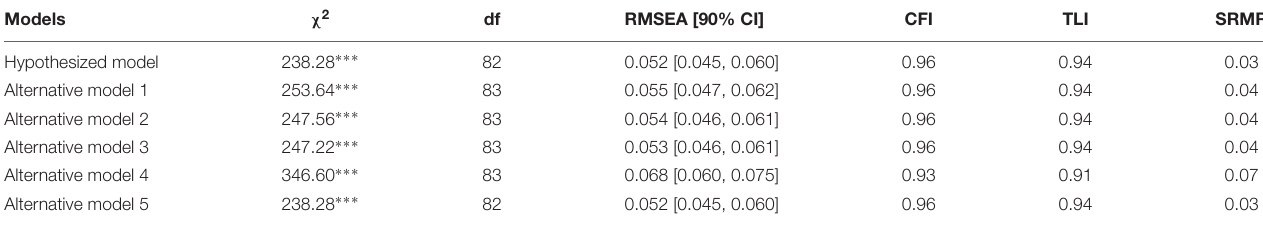
TABLE 2 | Fit indices of the hypothesized model and alternative models. Models χ 2 df RMSEA [90% CI] CFI TLI Hypothesized model